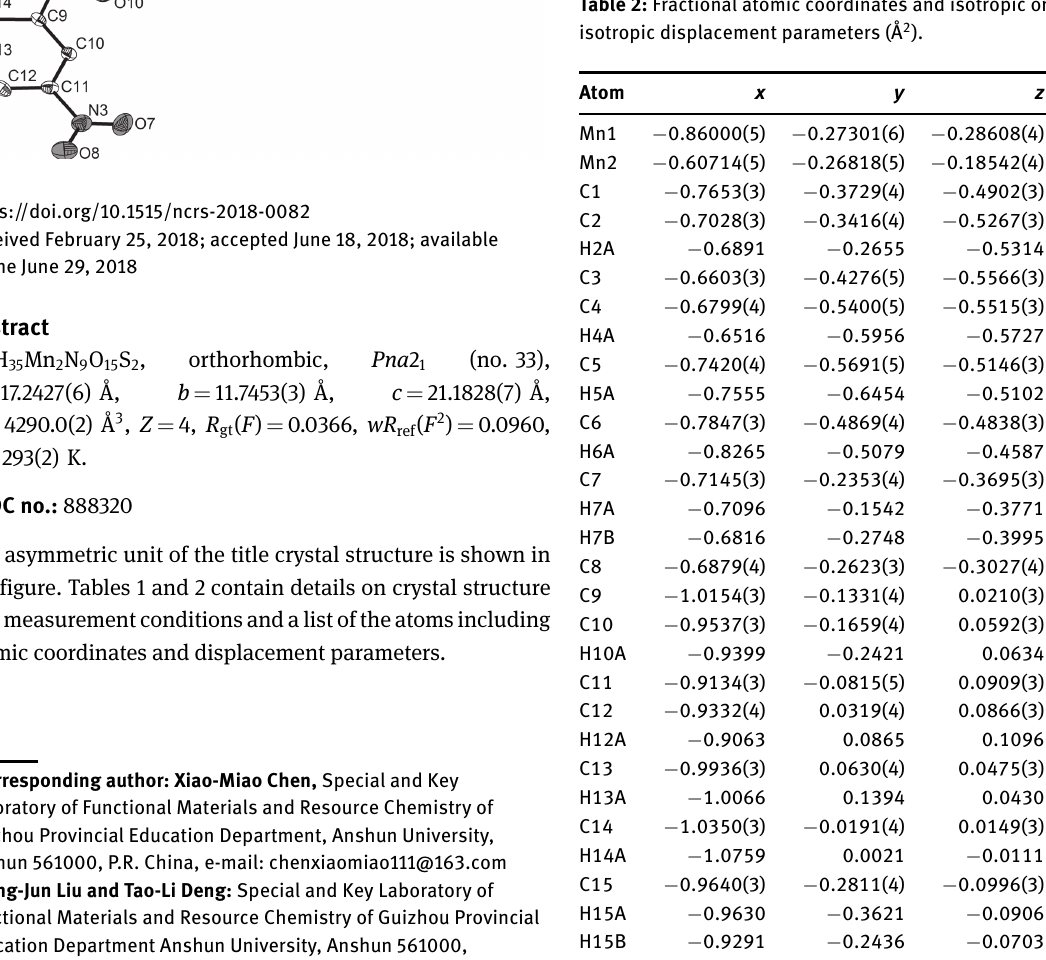
Table 2: Fractional atomic coordinates and isotropic or equivalent isotropic displacement parameters (Å 2